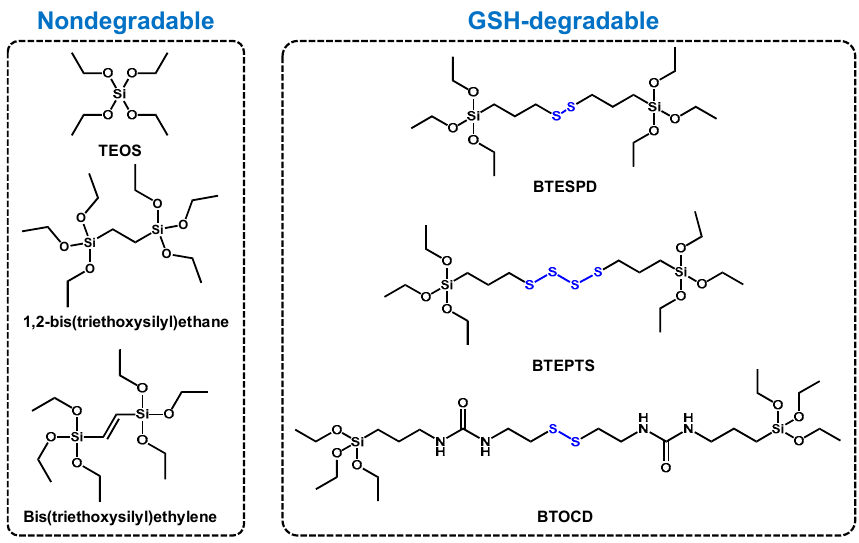
Figure 9. Chemical structure of the different organosilanes employed for the synthesis of biodegradable, bridged mesoporous silica nanoparticles.